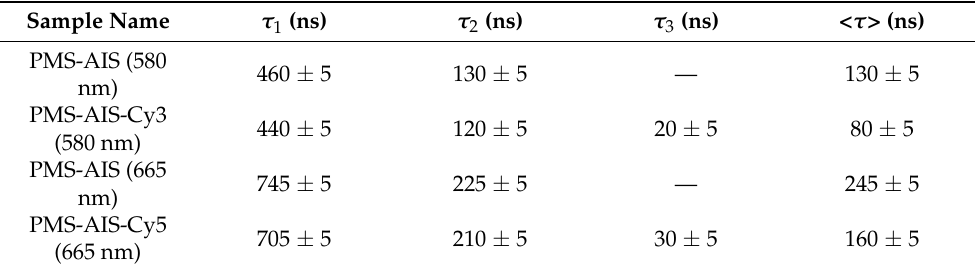
Table 1. PL lifetimes of PMS-AIS, PMS-AIS-Cy3 and PMS-AIS-Cy5 measured at 580 and 665 nm.